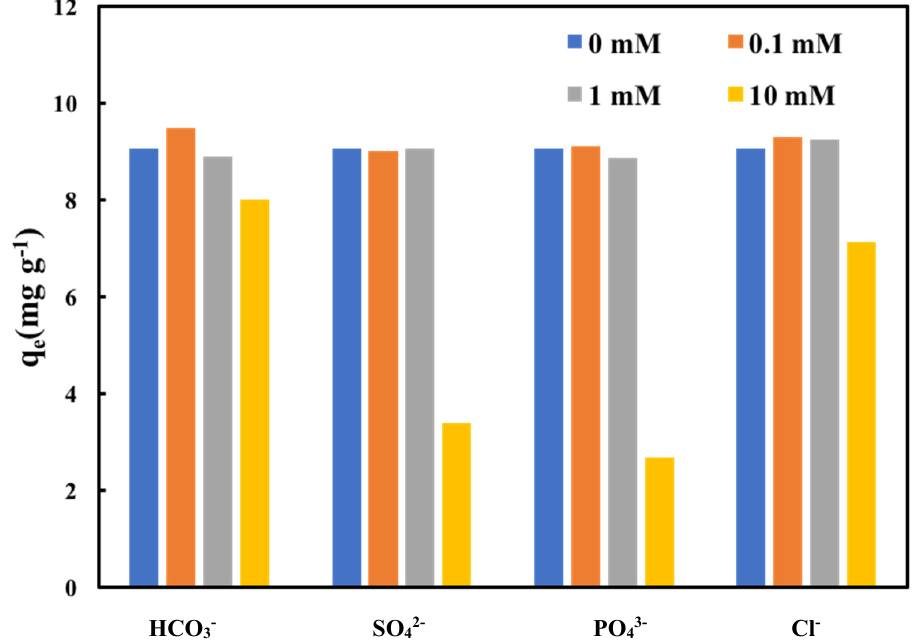
Figure 8. Effect of co-existing ions on the As removal property of the D-Mn gel.